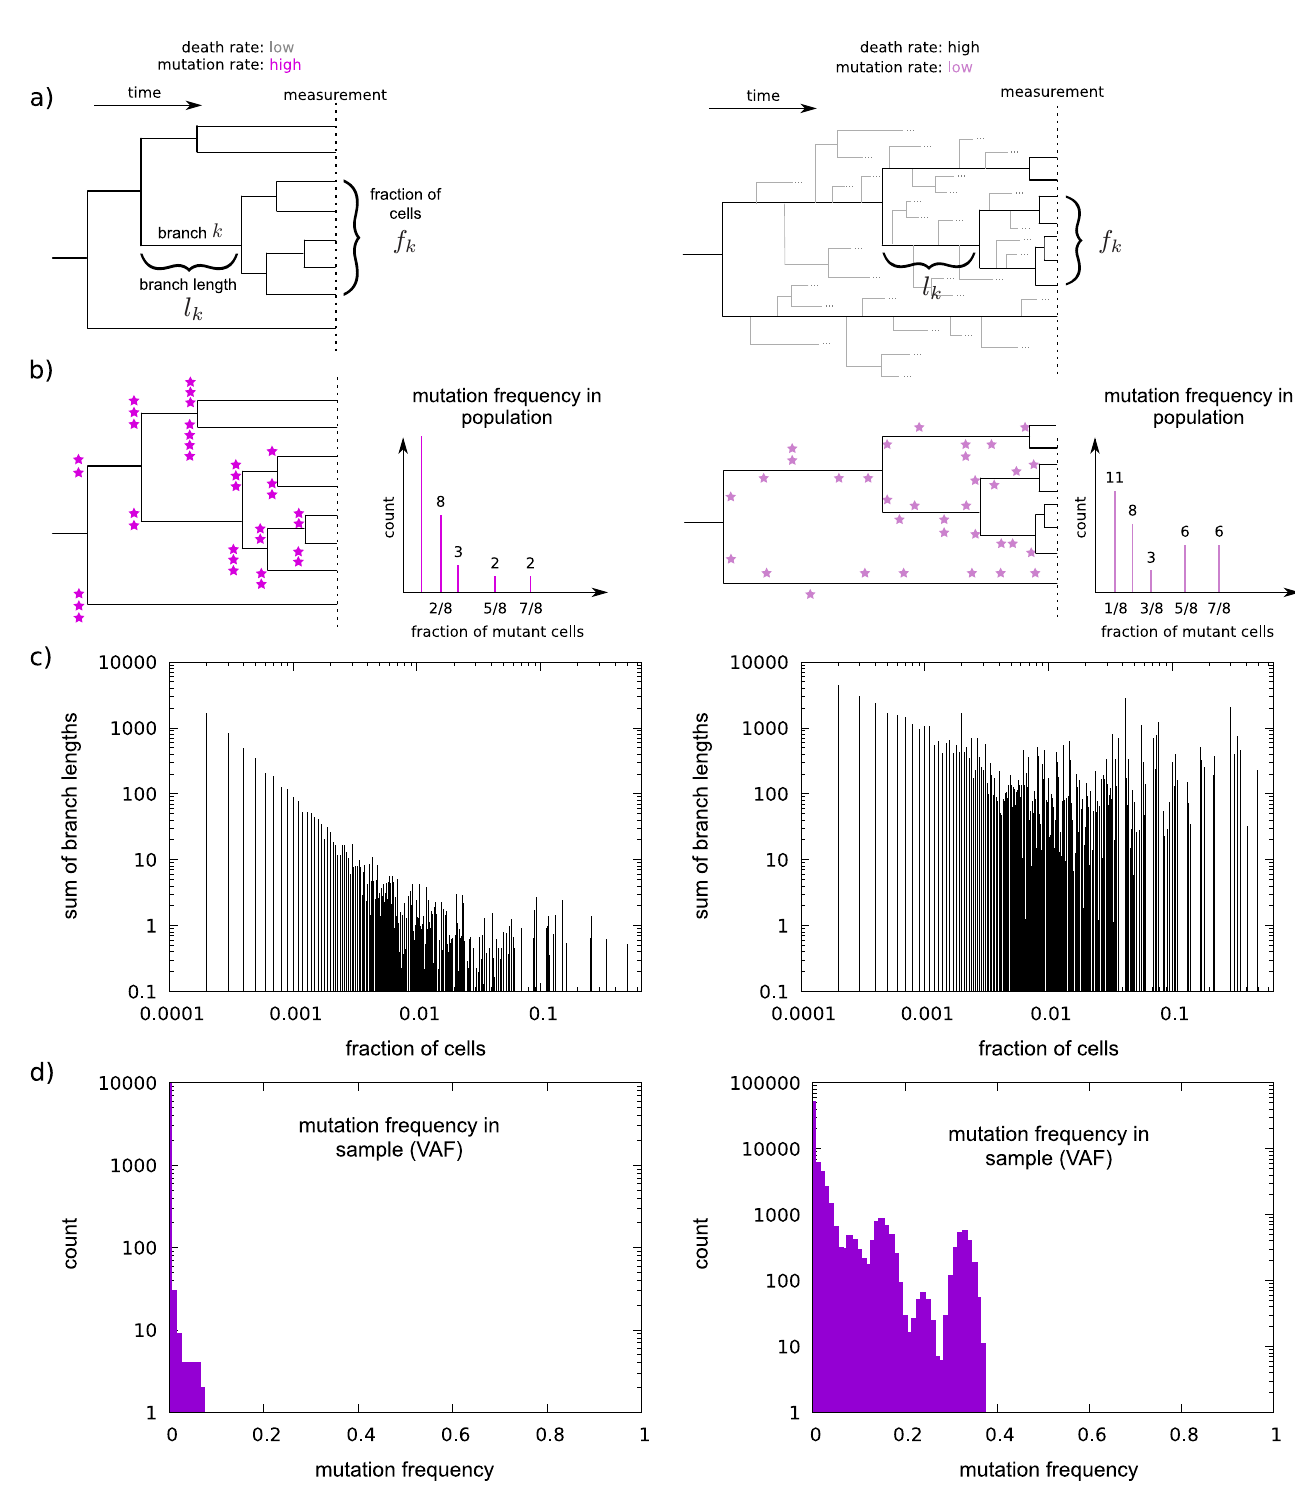
Fig 1. Distinguishing mutation rate and cell death intensity based on variant allele frequencies. Two possible scenarios for the generation of mutations along cell lineage trees. A) Different death-to-birth ratios lead to different lineage tree shapes. Bifurcations are cell divisions, leaves are cells comprising the bulk sequencing sample. Note that the (surviving) tree topologies are the same, only branch lengths differ. B) Mutations, symbolized by purple stars, accumulate at cell divisions. High death-to-birth ratio and low mutation rate can lead to the same number of observed mutations as low death-to-birth ratio and high mutation rate, however, the mutation spectrum of the two trees are different. C) For simulated trees of 10 4 leaves, the differences in the branch length distribution are